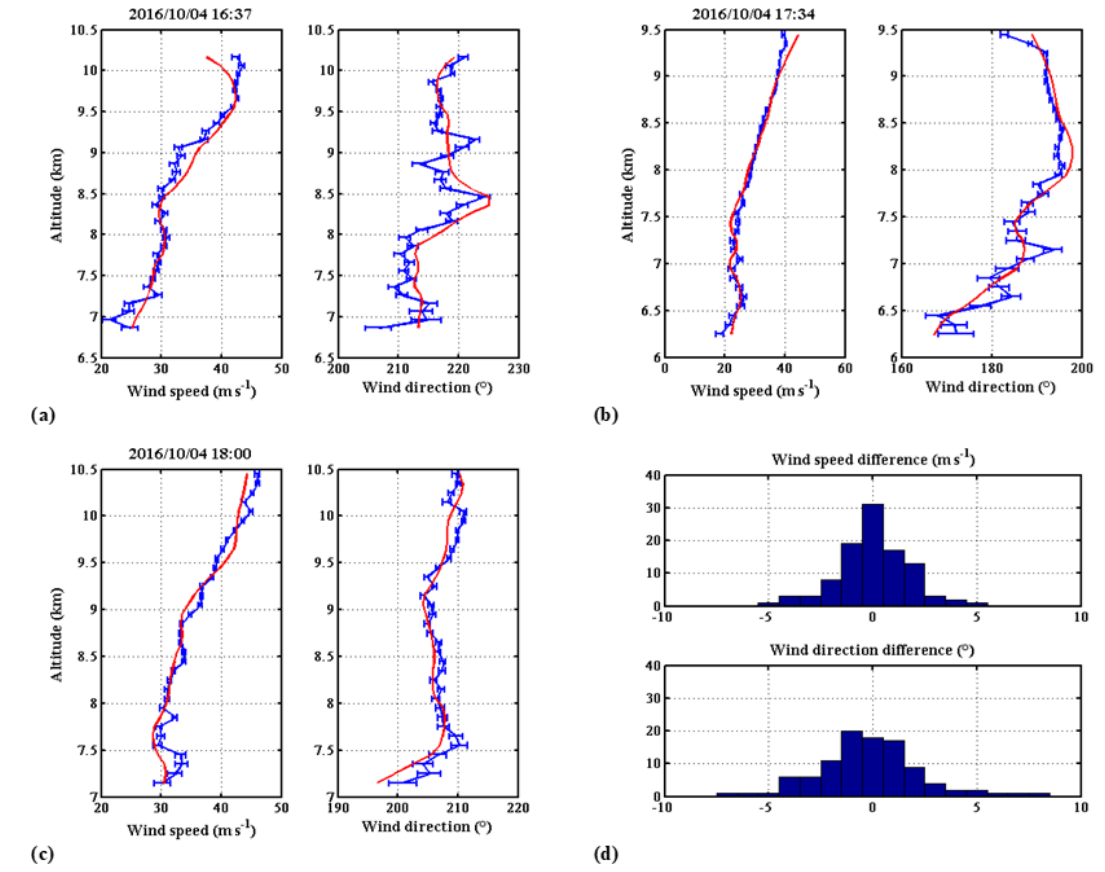
Figure C2. HSRD-LNG VAD wind profiles (blue) with calculated error bars (standard deviation) and collocated radiosonde measurements (red) for NAWDEX-EPATAN VADs performed on 4 October 2016 for three dropsondes launched at (a) 16:30, (b) 17:30, and (c) 18:00UTC. (d) Histogram of differences of HLOS wind speeds between HSRD-LNG, and related dropsonde measurements over the three vertical